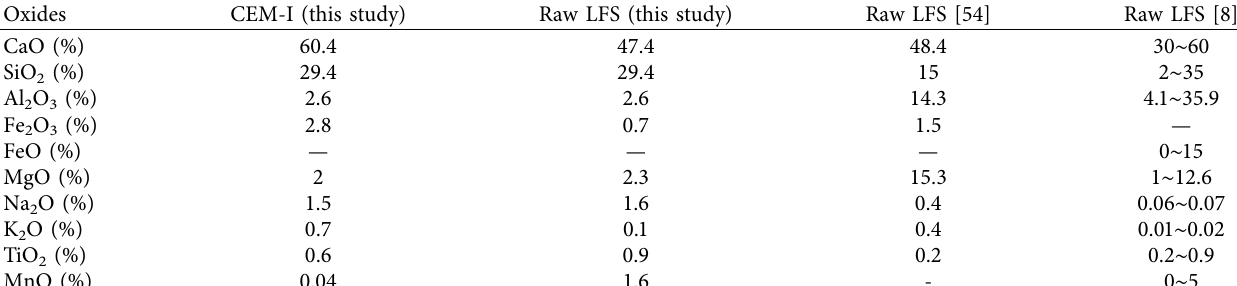
Table 2: Chemical composition of CEM-I and raw LFS used in this study.